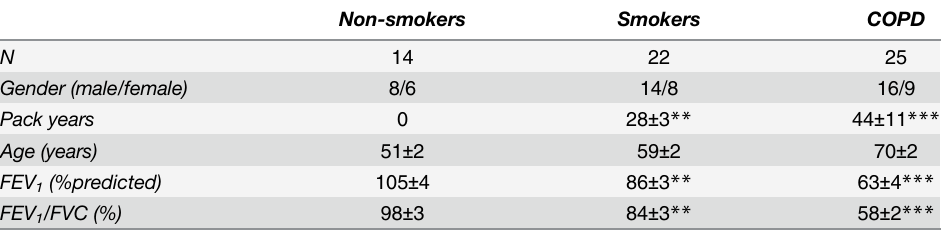
Table 2. Serum participant details. FEV 1 : Forced expiratory volume in one second; FVC: forced vital